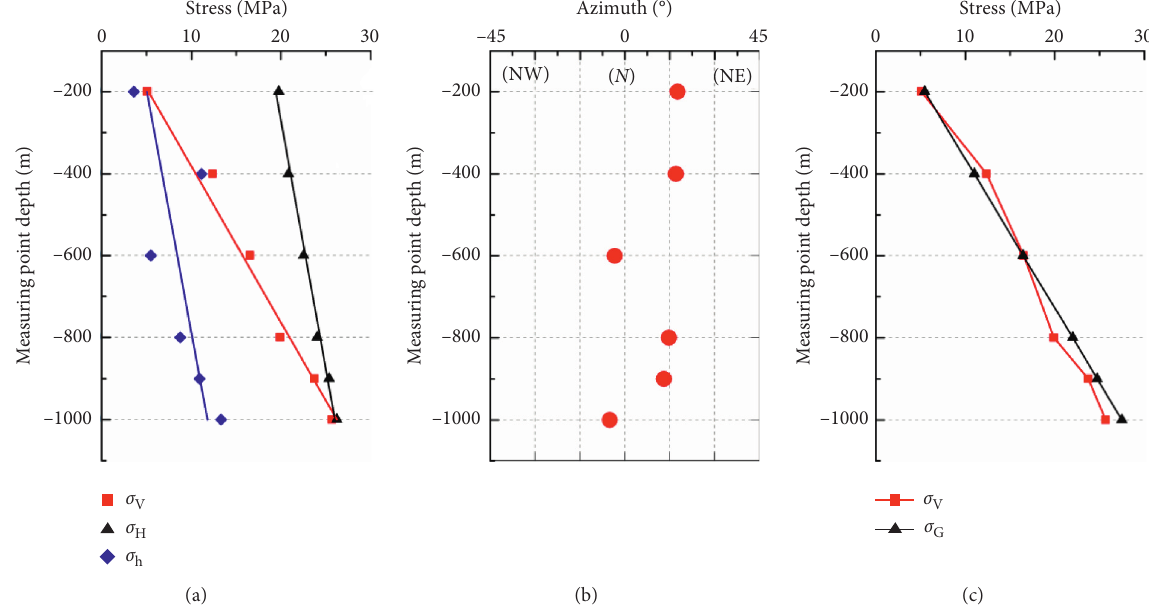
Figure 7: Distribution and variation of in situ stress. (a) σ